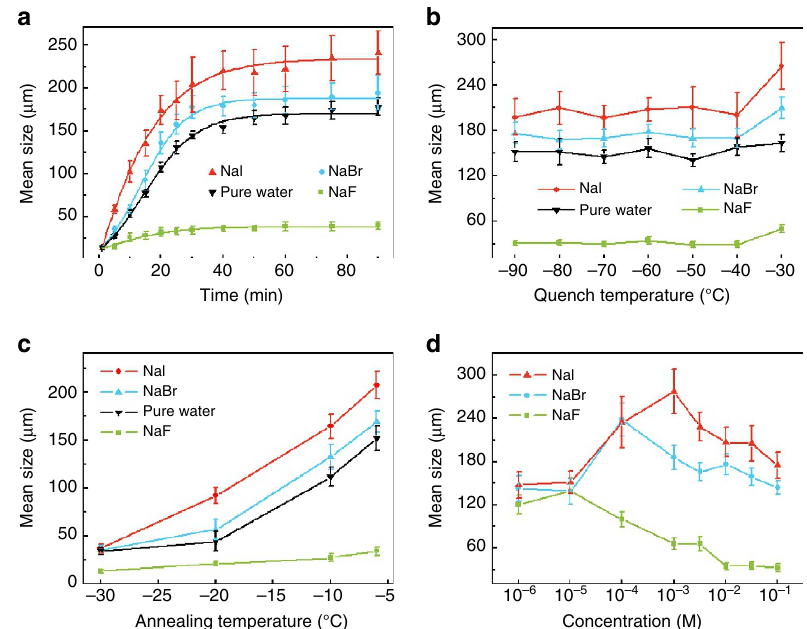
Figure 3 | Grain size variation. The mean grain size of the ice crystals recrystallized from pure water and NaF, NaBr and NaI aqueous solutions at: ( a ) Different annealing times with the quench temperature of (cid:2) 60 (cid:2) C and annealing temperature of (cid:2) 6 (cid:2) C; ( b ) Various quench temperatures with an annealing temperature of (cid:2) 6 (cid:2) C and annealing time of 45min; ( c ) Different annealing temperatures with a quench temperature of (cid:2) 60 (cid:2) C and an annealing time of 45min; ( d ) Various concentrations of salts with quench and annealing temperatures of (cid:2) 60 (cid:2) C and (cid:2) 6 (cid:2) C, respectively, and an annealing time of 45min. Note that the mean size of ice crystals obtained in NaF, NaBr and NaI peaked at concentrations of 10 (cid:2) 5 M, 10 (cid:2) 4 M and 10 (cid:2) 3 M, respectively. For the experiments shown in ( a – c ) the concentration of salts was 0.01M. The error bars represent the